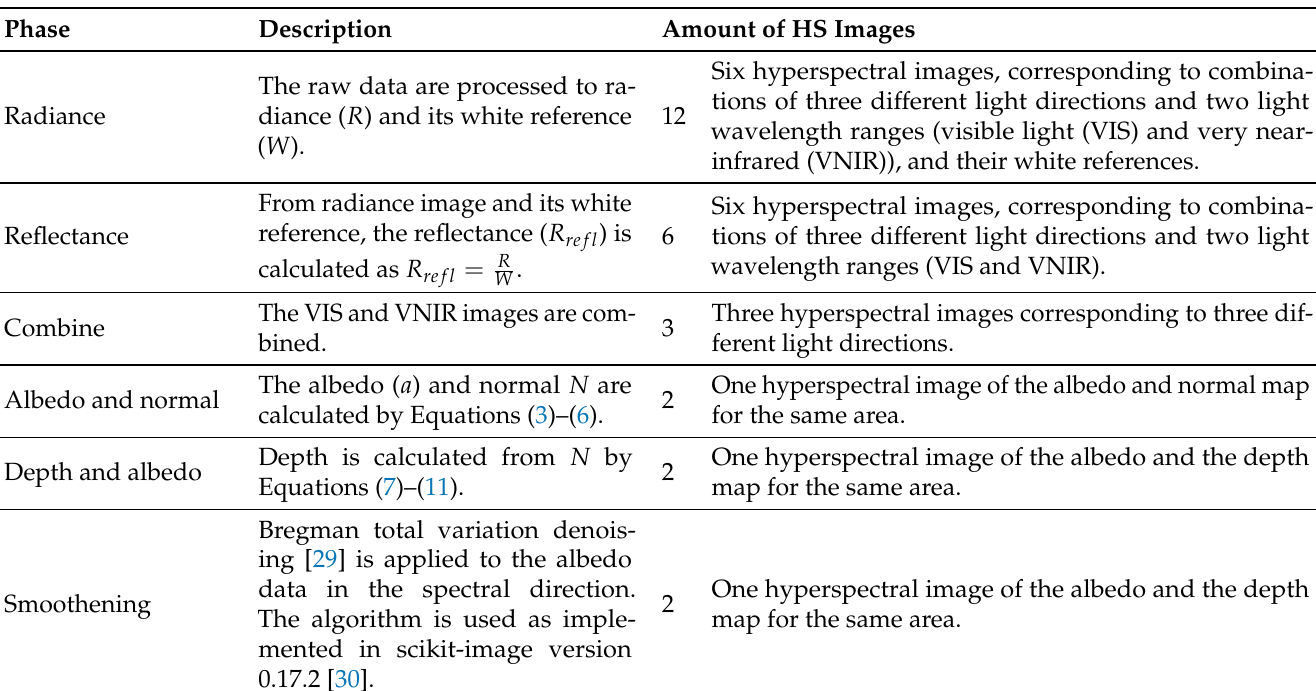
Table 2. The image processing